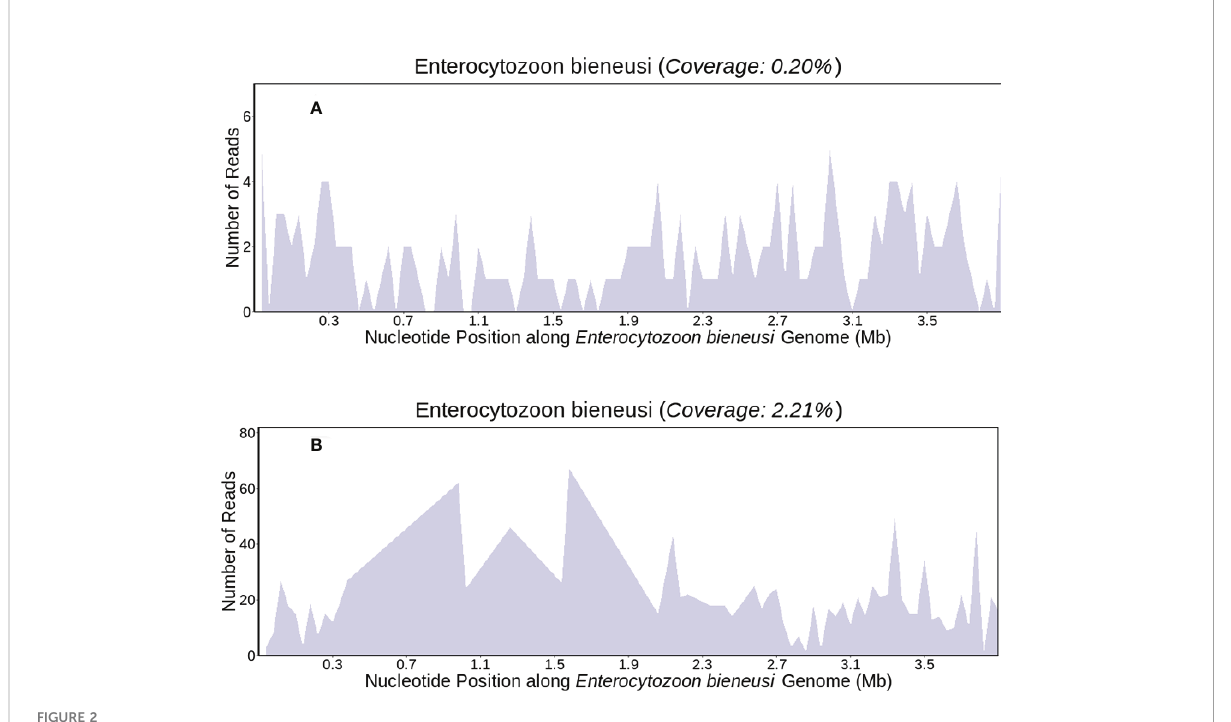
FIGURE 2 The patient ’ s ascites mNGS coverages mapped to (E. bieneusi) (DNA/RNA) (A, B)